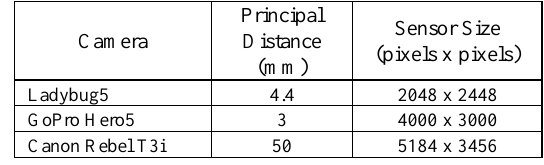
Table 1. Specifications of the cameras used in the experiments